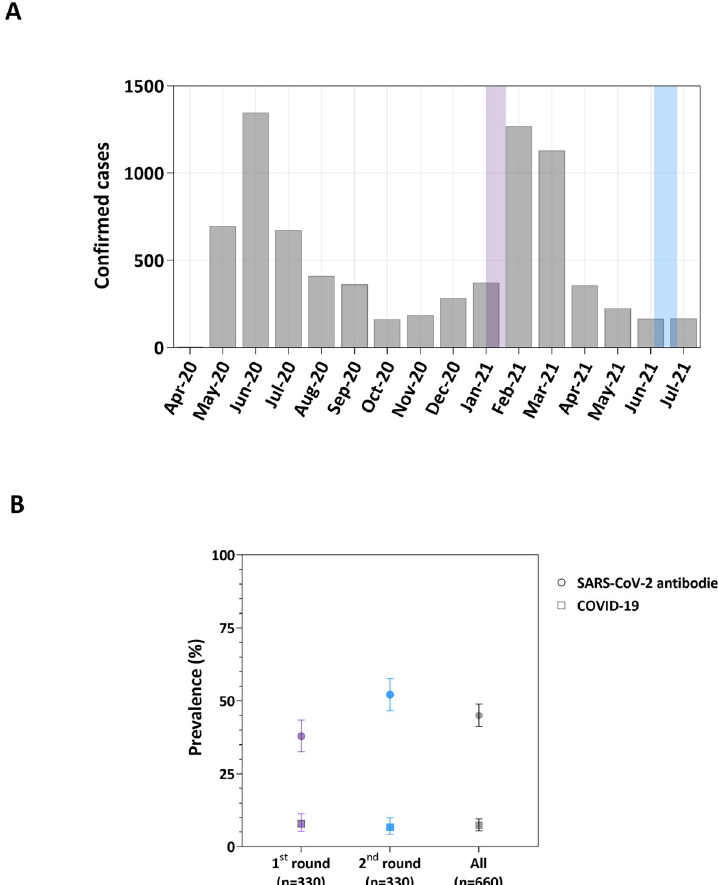
Fig 2. COVID-19 cases in Cruzeiro do Sul, Brazil, between April 2020 and July 2021 and period prevalence of SARS-CoV-2 infection and clinically apparent COVID-19 in 5 years-old children as measured in January 2021 (first study round) and June-July 2021 (second study round). (A) Monthly cases of COVID-19 notified in the municipality of Cruzeiro do Sul, between April 2020 and July 2021. Light purple and light blue shaded areas represent the dates of follow-up assessment in January 2021 and June-July 2021, respectively. Data source: State Secretary of Health, Acre. Data available daily at: http://saude.acre.gov.br/. (B) Circles show the proportions (%) of children positive for anti-SARS-CoV-2 antibodies in the first study round (light purple), in the second round (light blue), and in both rounds combined (grey). Squares show the period prevalence (%) of clinically apparent COVID-19 (see the main text for definition) among these same children, as estimated in the first study round (light purple), in the second round (light blue), and in both rounds combined (grey). A total of 330 children were assessed during each study round. Error bars indicate 95% confidence